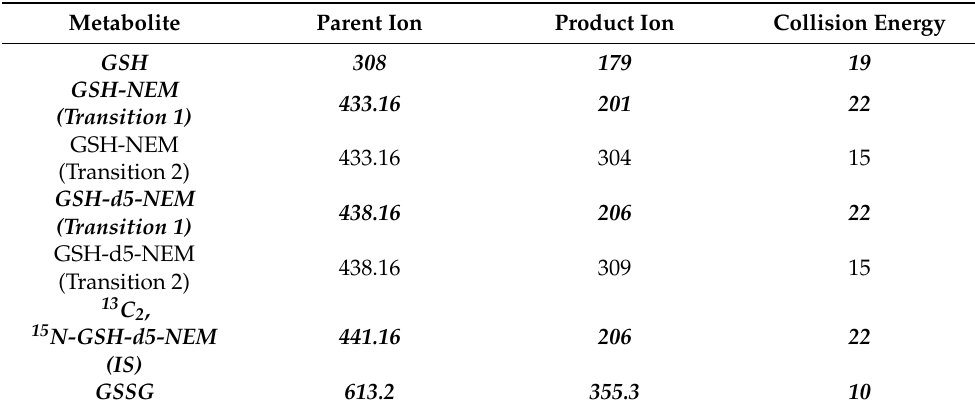
Table 1. Multiple reaction monitoring (MRM) table of transitions for glutathione and glutathione derivatives. Transitions highlighted in bold and italic were used for